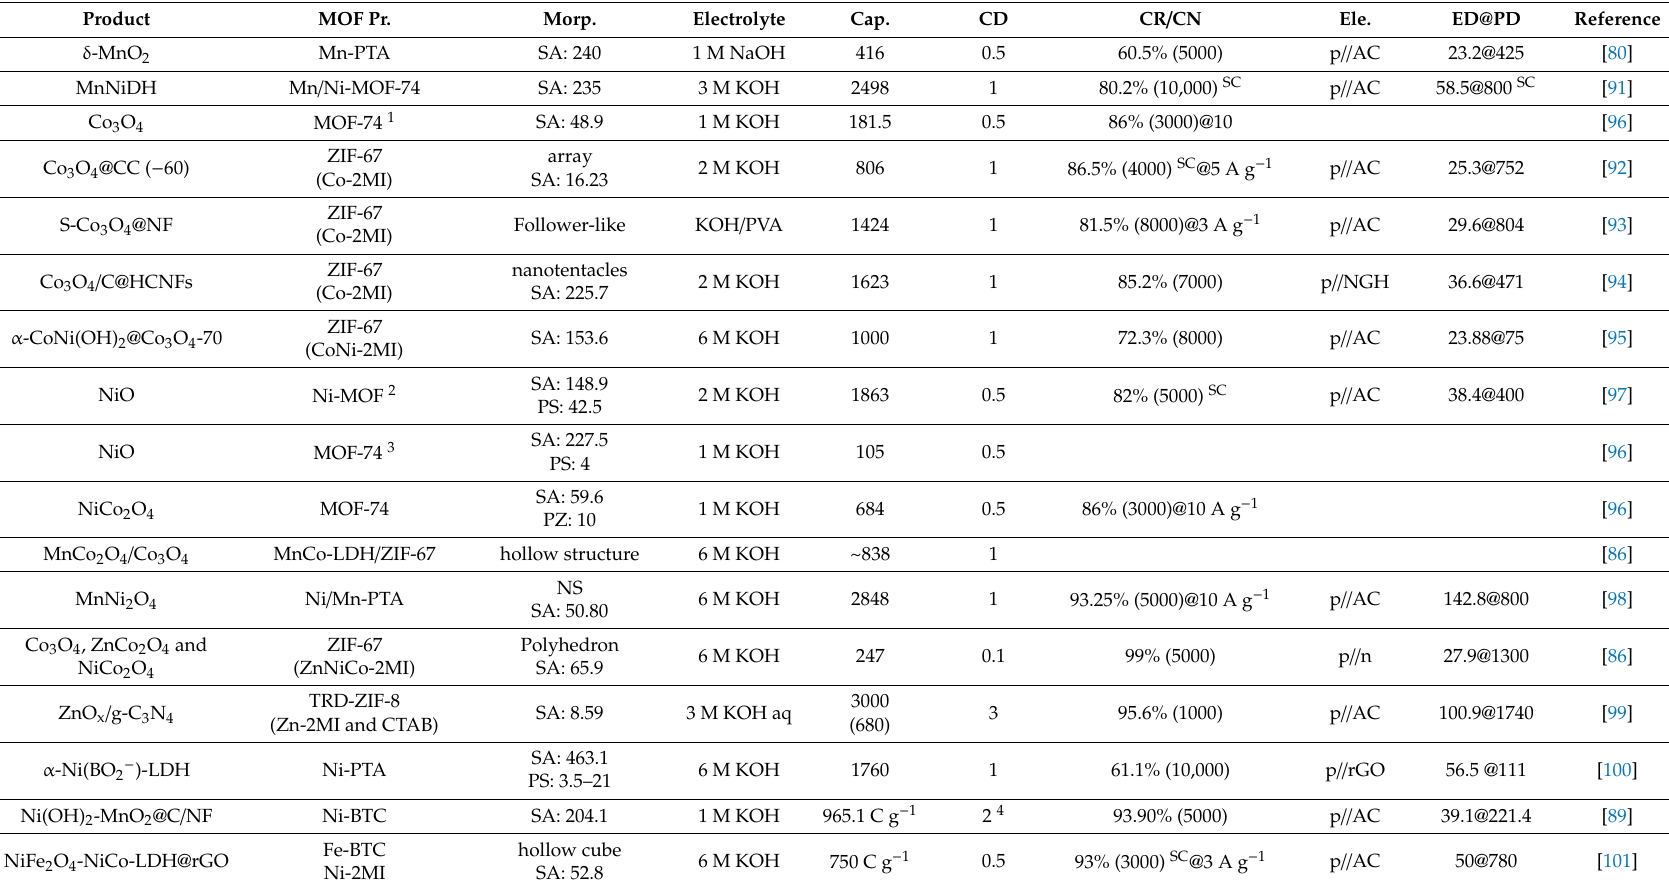
Table 3. Selected MOF-derived MO x -based electrodes for SC